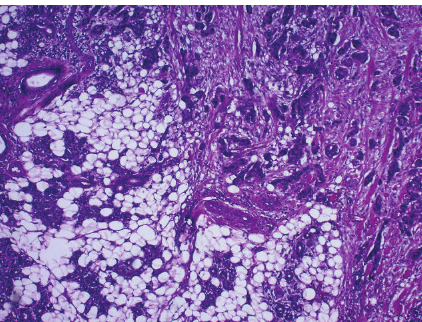
Figure 2: Parotid: H&E × 40: neoplastic ducts (right upper part of the image) invading the parotid parenchyma (left lower part of the image).